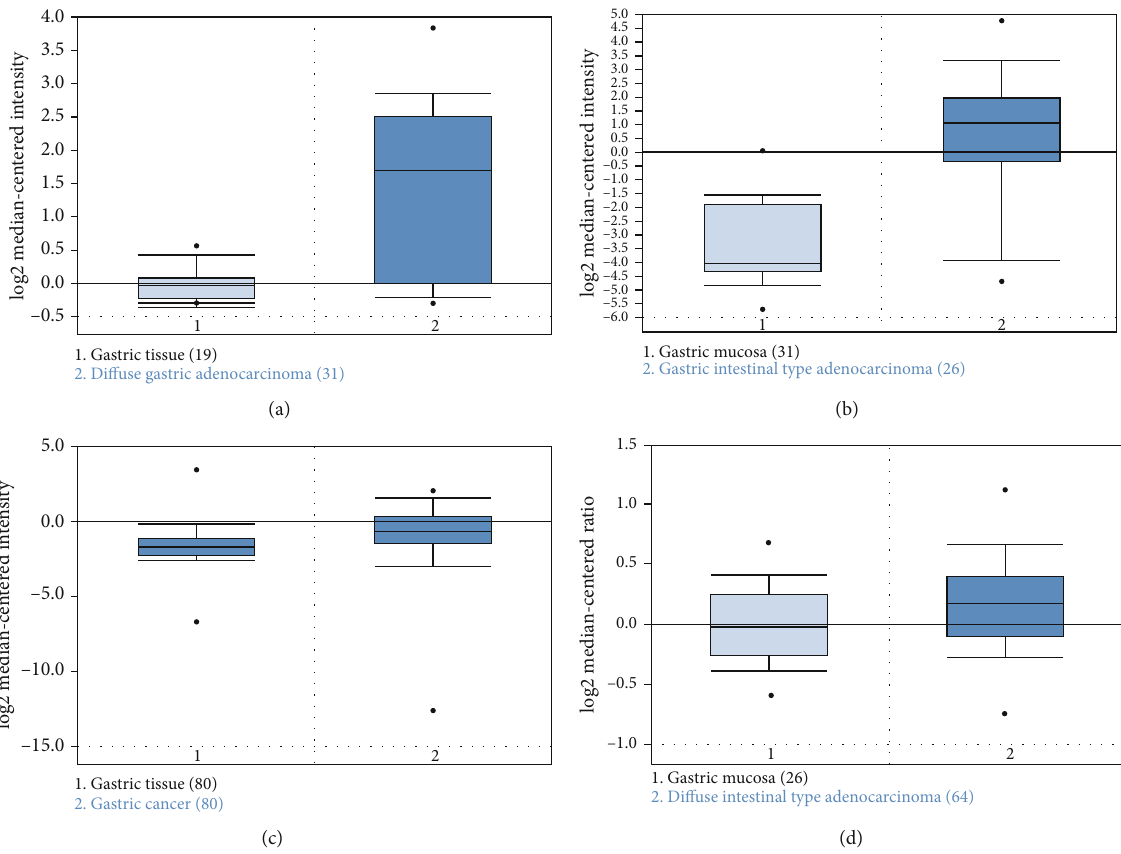
Figure 1: VSNL1 expression in gastric cancer patients. (a – d) The relative level of VSNL1 mRNA was signi fi cantly higher in gastric cancer than normal tissues. All data collection and statistical analyses were performed on the Oncomine platform